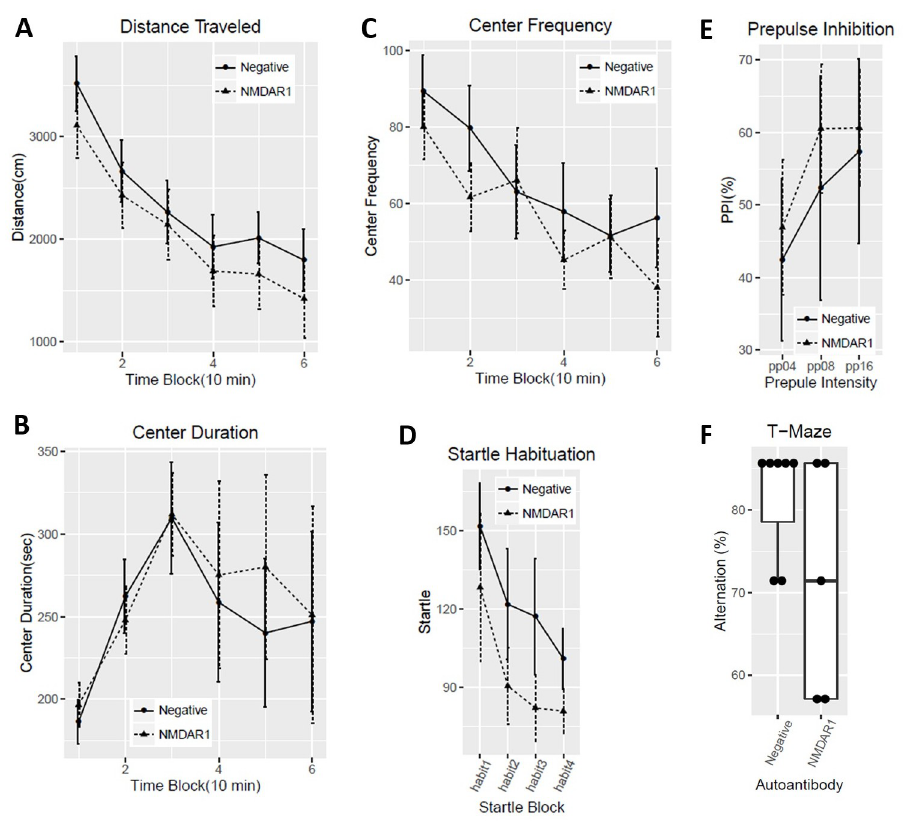
Fig 3. Behavioral analysis of the mice in open field locomotion, prepulse inhibition, and T-maze tests. Negative control male mice (n = 7); positive NMDAR1 male mice (n = 5). (A) No difference (F(1,10) = 0.45, p = 0.52) in total distances traveled was observed between the two groups, 10 min for each time-block. (B) There is no difference (F (1,10) = 0.06, p = 0.81) in center duration between the two groups. (C) No difference (F(1,10) = 0.38, p = 0.55) was observed between the two groups in frequencies for mice entering the center. (D) There is no difference (F(1,10) = 0.07, p = 0.8) in startle habituation between the two groups of mice. (E) No difference (F(1,10) = 0.05, p = 0.84) was observed in prepulse inhibition across pp4, pp8, pp16 prepulse levels between the two groups. (F) Alternation percentages of individual mice were present as boxplot. There was a trend (t(10) = 1.81, p = 0.06, one-tail t test) of lower spontaneous alternation in T-maze in mice carrying the anti-NMDAR1 autoantibodies. All data are present as Mean+SEM.